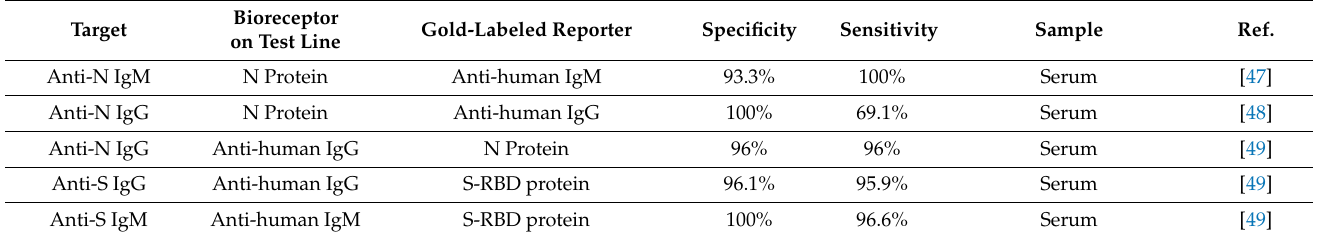
Table 2. Overview of gold-based lateral flow assays for detection of antigen and antibodies of